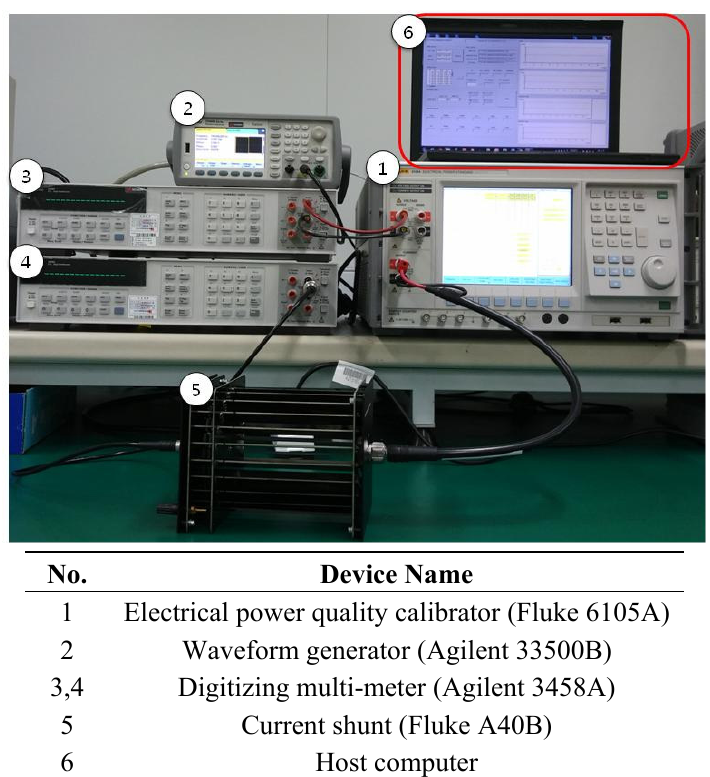
Figure 8. Hardware implementation for tests using real